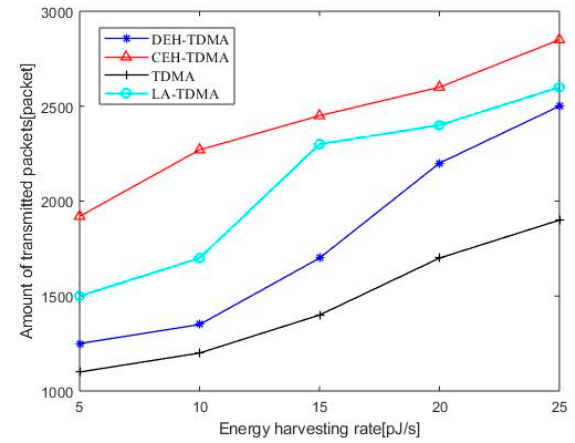
Figure 5. The number of packets transmitted as a function of energy harvesting rate.